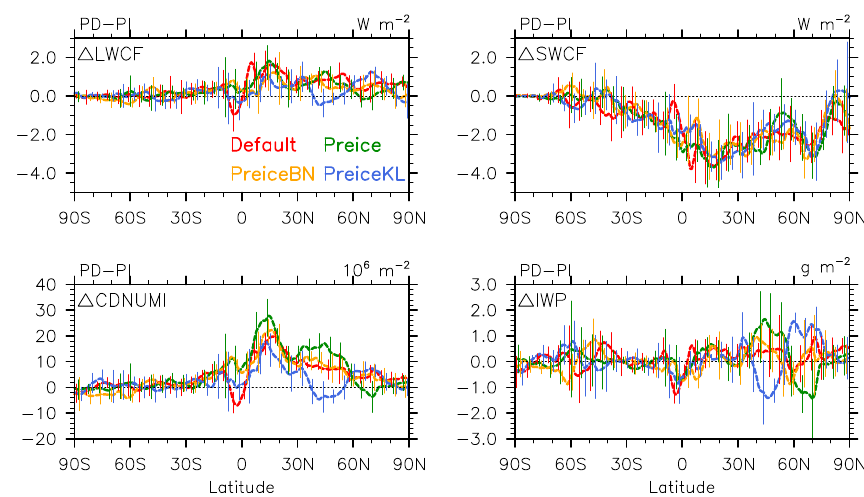
Figure 9. Changes (present-day minus pre-industrial times) in annual and zonal mean distributions of long-wave and shortwave cloud forcing (LWCF, SWCF), column cloud ice number concentration (CDNUMI) and ice water path (IWP) for Default, Preice, PreiceBN and PreiceKL experiments. The vertical bars overloading on solid lines indicate the ranges of 2 standard deviation calculated from the difference of each year for 5 years at different